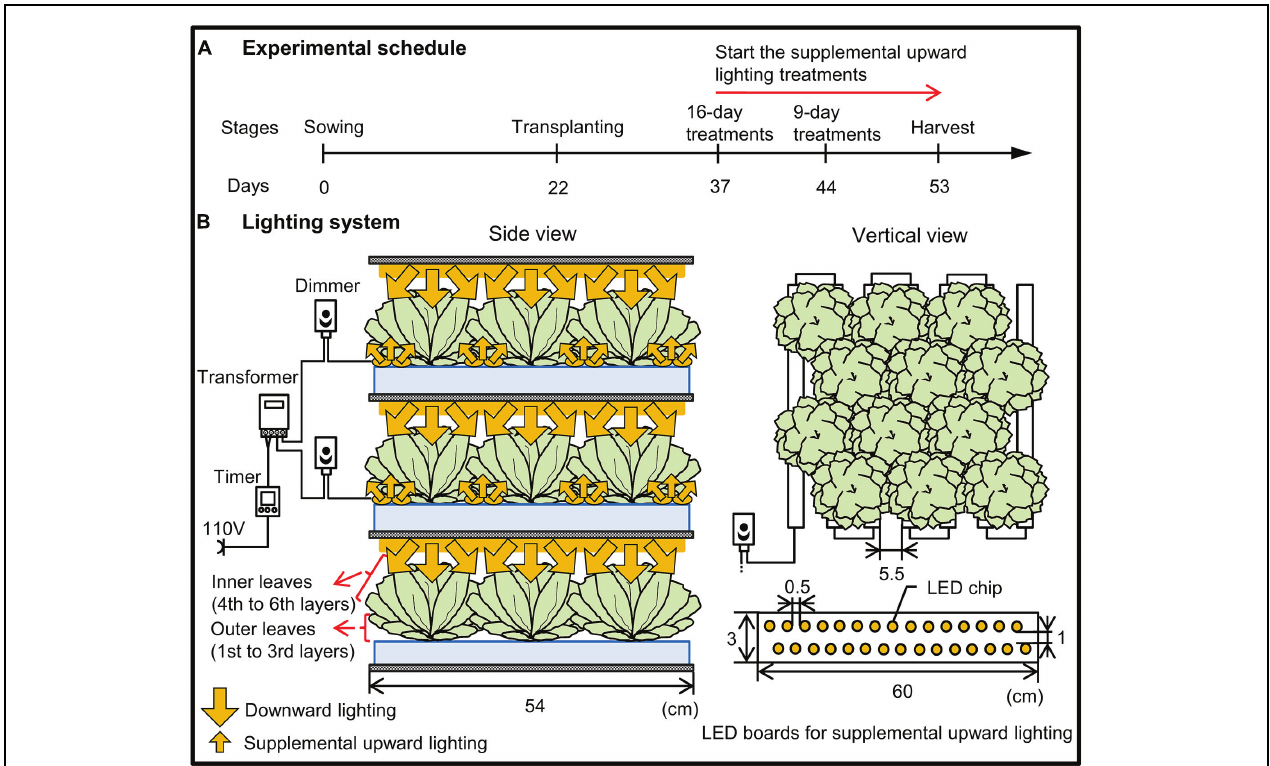
FIGURE 1 | Schematic diagram of the experimental schedule (A) and the lighting system (B) used in the present study. (A) At 22 days after sowing, the seedlings were transplanted into growth chambers equipped with 200 µ mol m − 2 s − 1 PPFD of downward-facing white, red, or blue LEDs and with light provided for 16 h per day. The supplemental upward lighting treatments were performed from 15 or 22 days after transplanting until harvest. (B) There were three vertically arranged cultivation beds for each light color. Lettuce grown in the top and middle layers received light from above (downward lighting), with supplemental upward lighting for 9 and 16 days, respectively. Lettuce grown in the bottom layer received light only from above, without any supplemental upward lighting. The treatment arrangement was the same for each LED color: lettuce was grown at 37 plants m − 2 , with 22 LED boards (each board containing two rows of LED chips) m − 2 used for supplemental upward lighting. A digital timer, dimmer, and transformer were used to maintain the light period (16 h, the same as the downward lighting) and light intensity (40 µ mol m − 2 s − 1